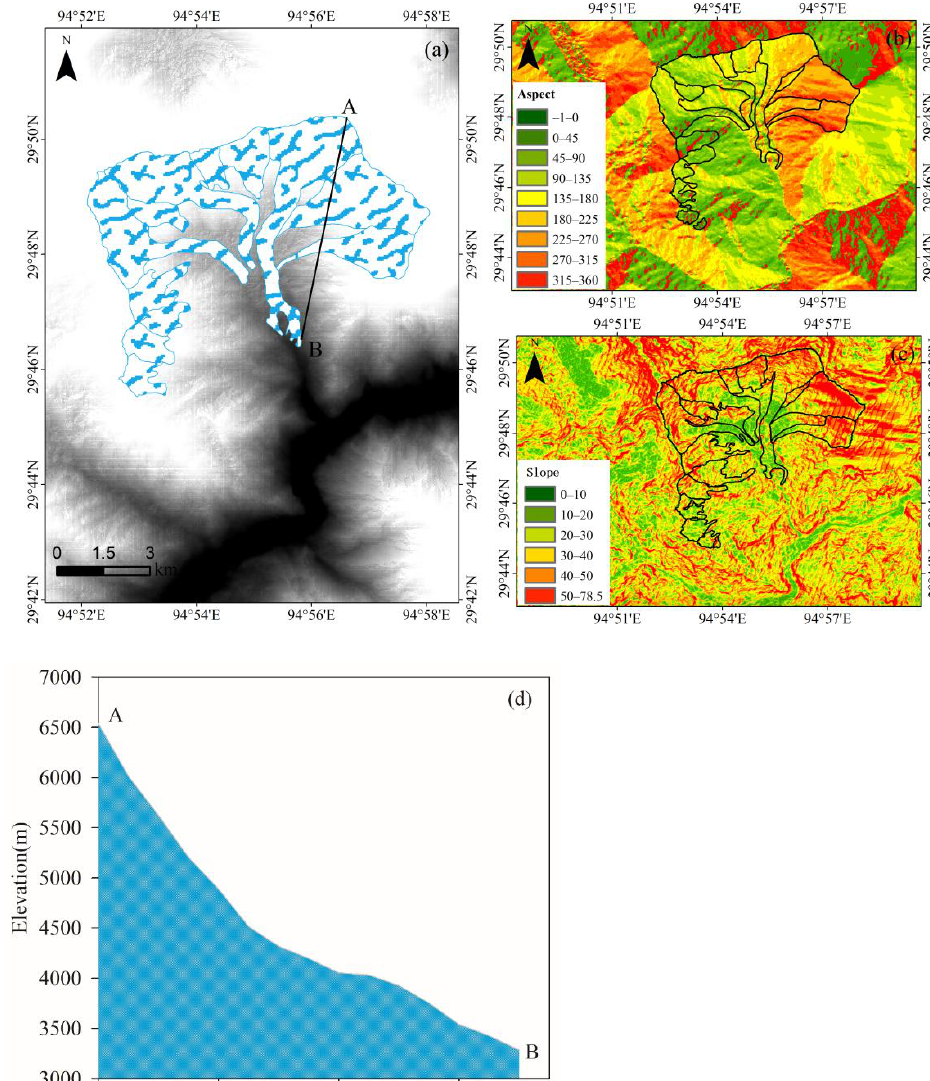
Figure 6. Glacier terrain based on SRTM in the Dongpu glacier, ( a ) points A to B on the Dongpu glacier as an example of the measurement of elevation differences. ( b ) The aspect of the glaciers in Sedongpu basin within the black line. ( c ) The slope of the glaciers in Sedongpu basin within the black line. ( d ) The elevation difference between points A and B on the Dongpu glacier.